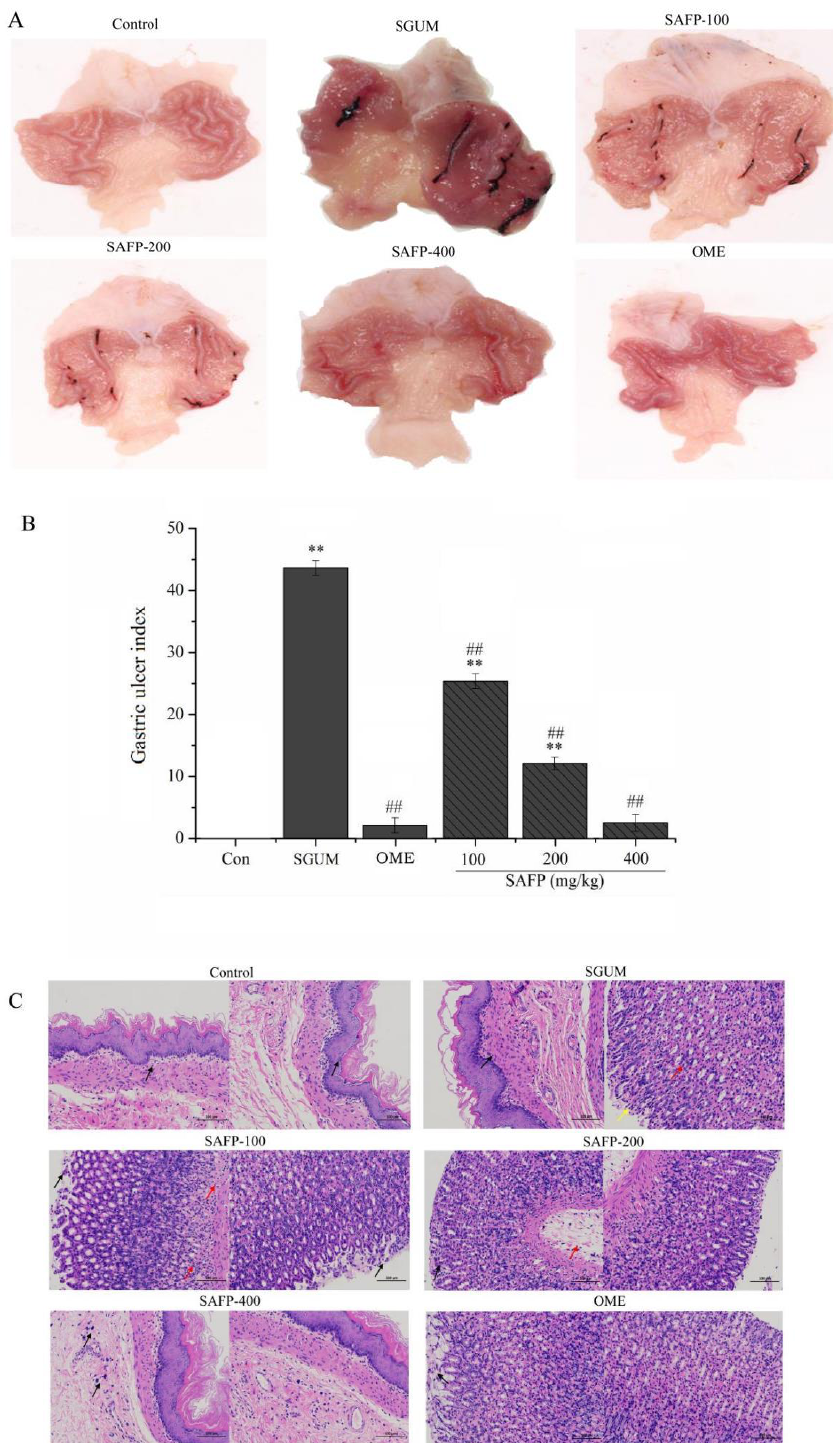
Figure 4. SAFP alleviates gastric mucosal injury. ( A ) The typical appearance of the gastric mucosa. ( B ) The gastric ulcer index (UI). ( C ) Pathological changes in lung tissues from each group of mice by H&E staining. Data are represented by mean ± SD ( n = 10). ** p < 0.01, vs. control group. ## p < 0.01, vs. SGUM group.